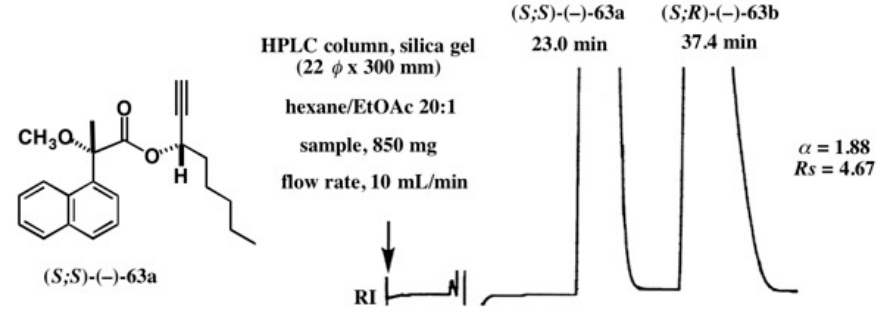
Figure 41. Preparative HPLC separation of 1-octyn-3-ol M α NP esters 63a / 63b : silica gel column, theoretical plate number, n = 9,500–11,600; sample (850 mg) was injected. Reprinted with permission from [59].